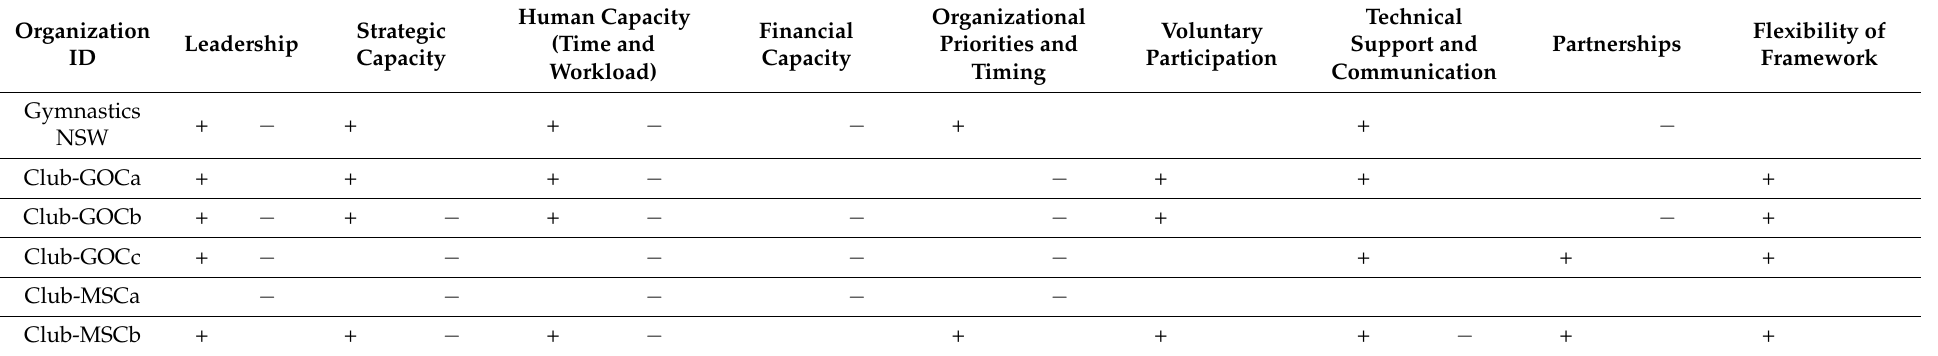
Table 2. Summary of facilitators and barriers to implementing the Health-Promoting Gymnastics Clubs